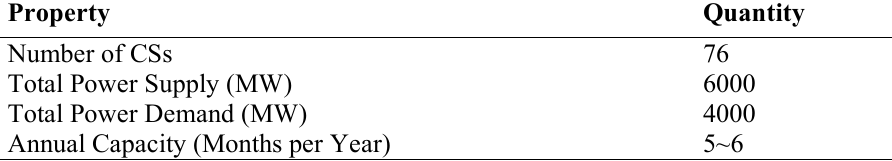
Table 2 . General information of Iran’s natural gas compressor